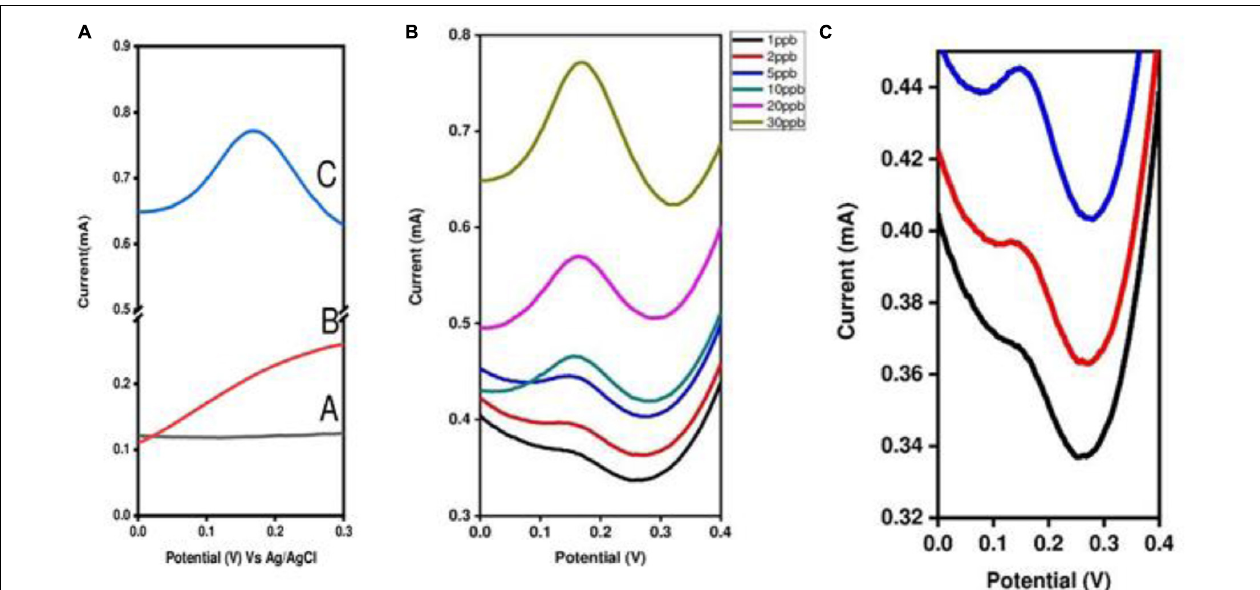
FIGURE 9 | Determination of Hg(II) ions by the DPSV technique (A) with three different electrodes at 30 ppb [(A) PANI/GO composite, (B) only PANI, and (C) EDTA modified PANI/GO composite] and (B) from 1 to 30 ppb with an EDTA modified PANI/GO composite electrode. (C) Enlarged image for 1 to 3 ppb with an EDTA modified PANI/GO composite electrode.